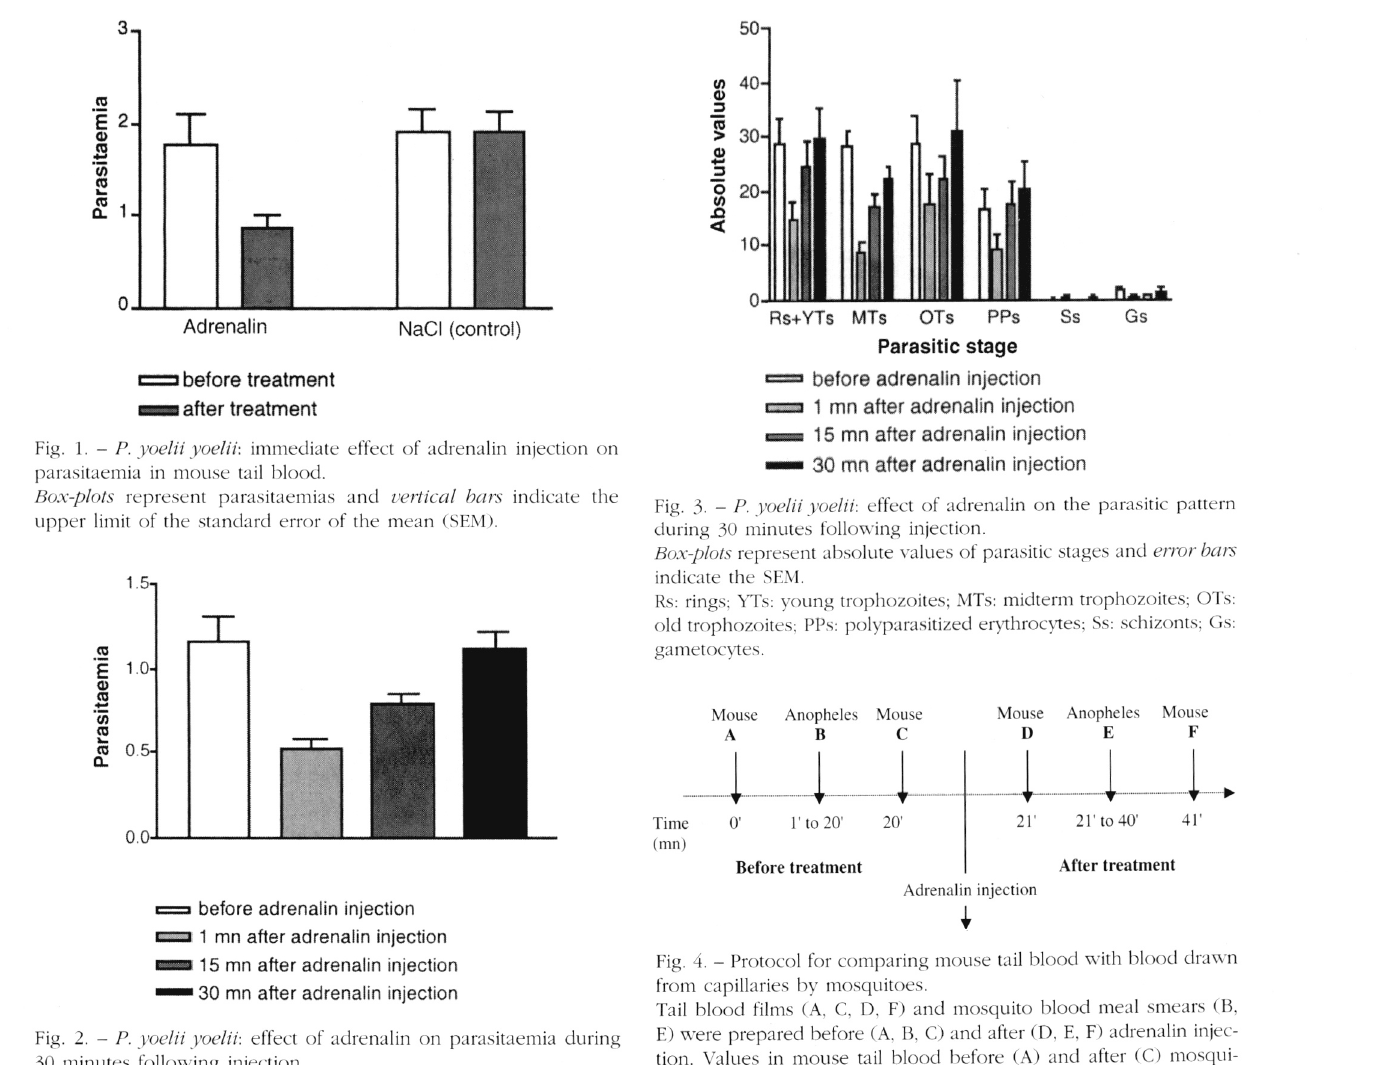
Fig. 2. - P. yoelii yoelii: effect of adrenalin on parasitaemia during 30 minutes following injection. Box-plots represent parasitaemias and error bars indicate the SEM.